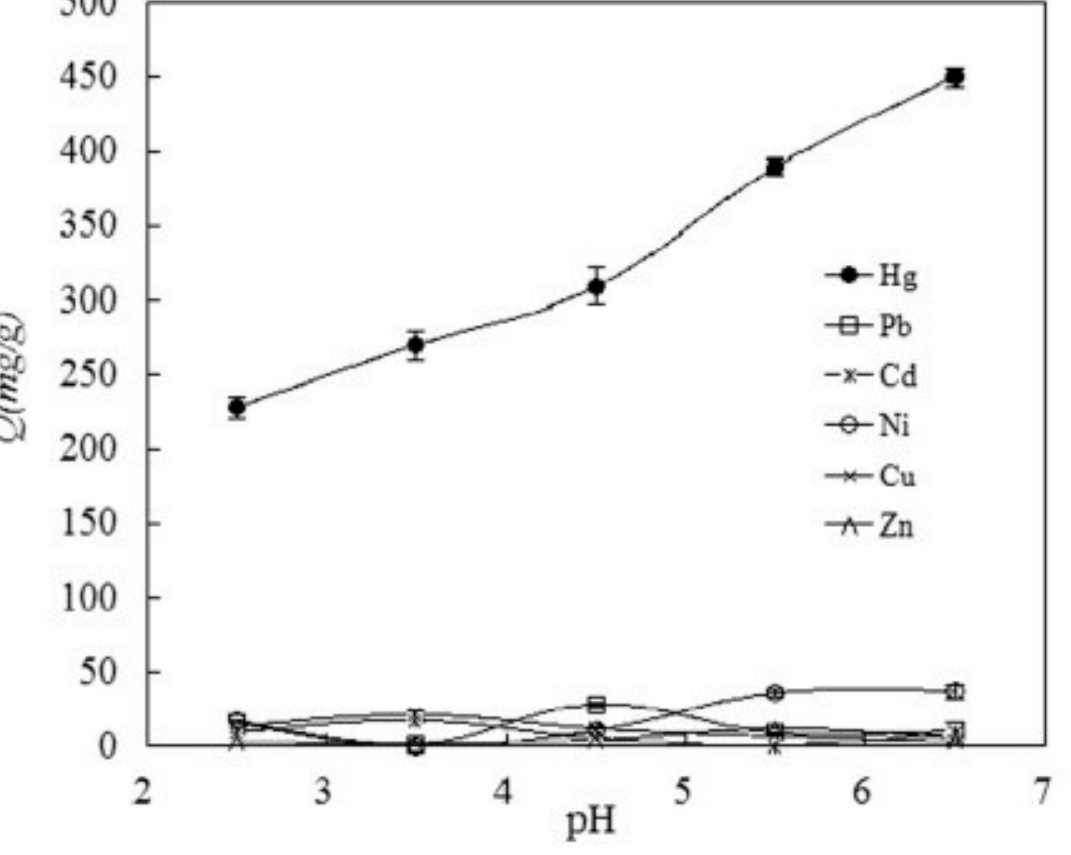
Figure 8. Effect of pH on the sorption value of polyacrylonitrile-2-amino-1,3,4-thiadiazole adsorbent for Hg 2+ ions (adsorbent dose used = 0.015g, Co = 10.0 mg/30.0 mL, pH 2.5–6.5, T = 298 K, 100 rpm). Reproduced with permission from reference [45].